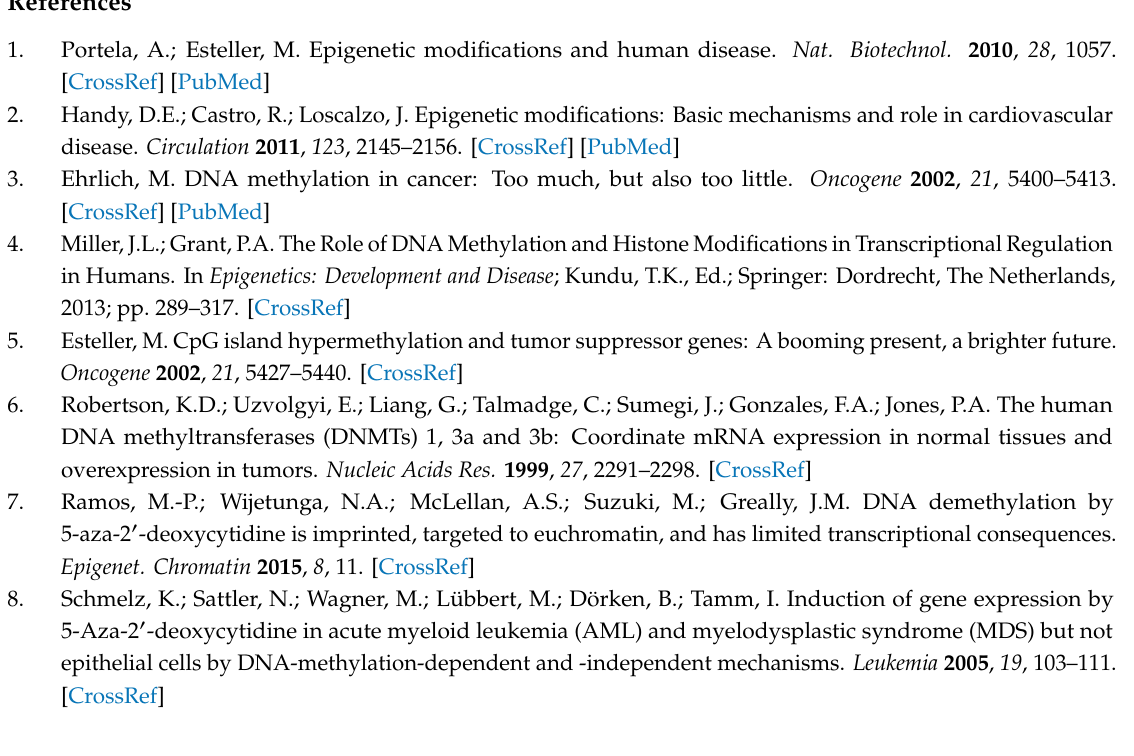
Figure S1: Downregulation and hypermethylation of CFTR in SGT; Figure S2: CFTR